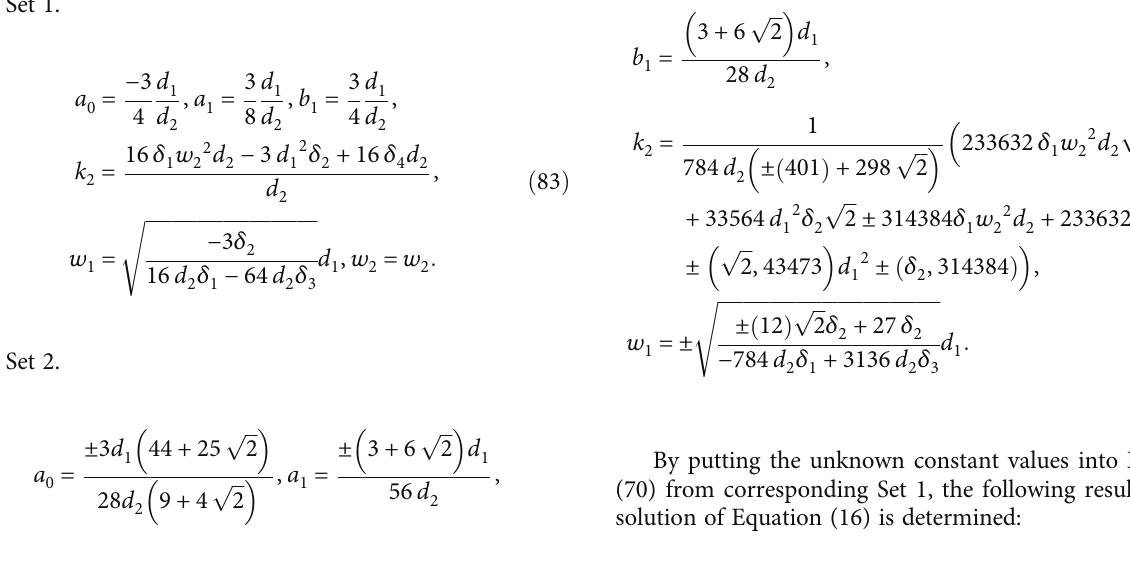
= 6, δ = δ = 0 : 6, δ = 0 : 1, w = 1, w = 0 : 01 1 2 4 3 1 2